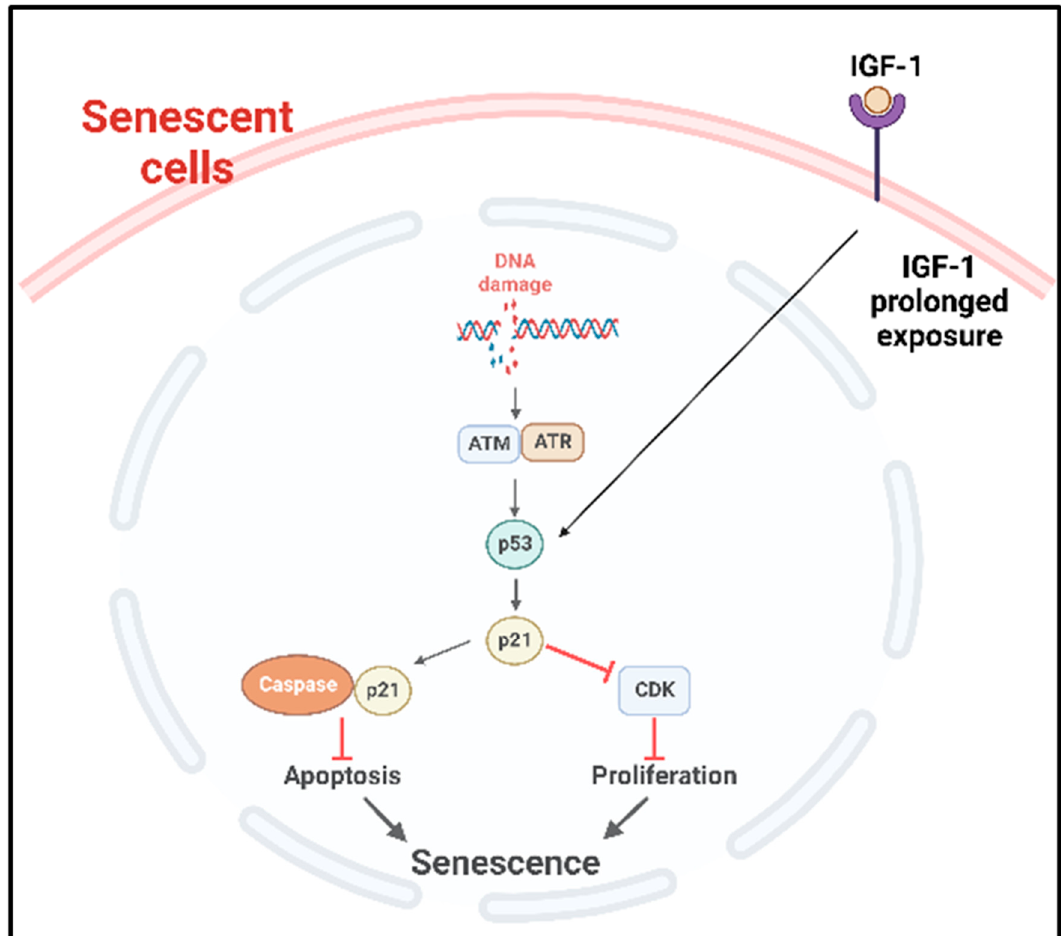
Figure 3. p53 mediated cellular senescence. In response to DNA damage caused by DNA damaging factors, the DDR pathway is activated with the concomitant activation of ATR or ATM which in turn stabilize p53. Prolonged exposure of the cancer cells to IGF-1 also causes the stabilization and activation of p53 pathway. Consequently, the downstream p53/p21cip1 are activated, which can then inhibit the apoptosis by binding with apoptotic genes including caspases and induce senes- cence. Activated p21 cip1 , which is a member of the CDK inhibitor, inhibits the cellular proliferation.